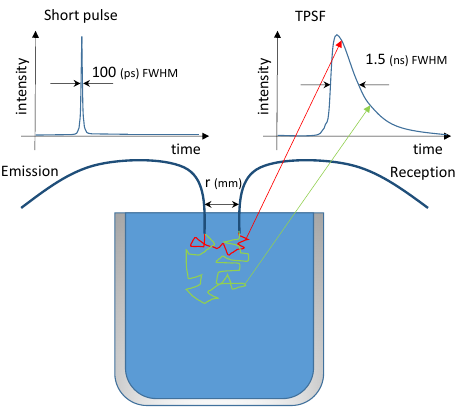
Figure 2. Principle of Time Resolved Optical Turbidity (TROT).